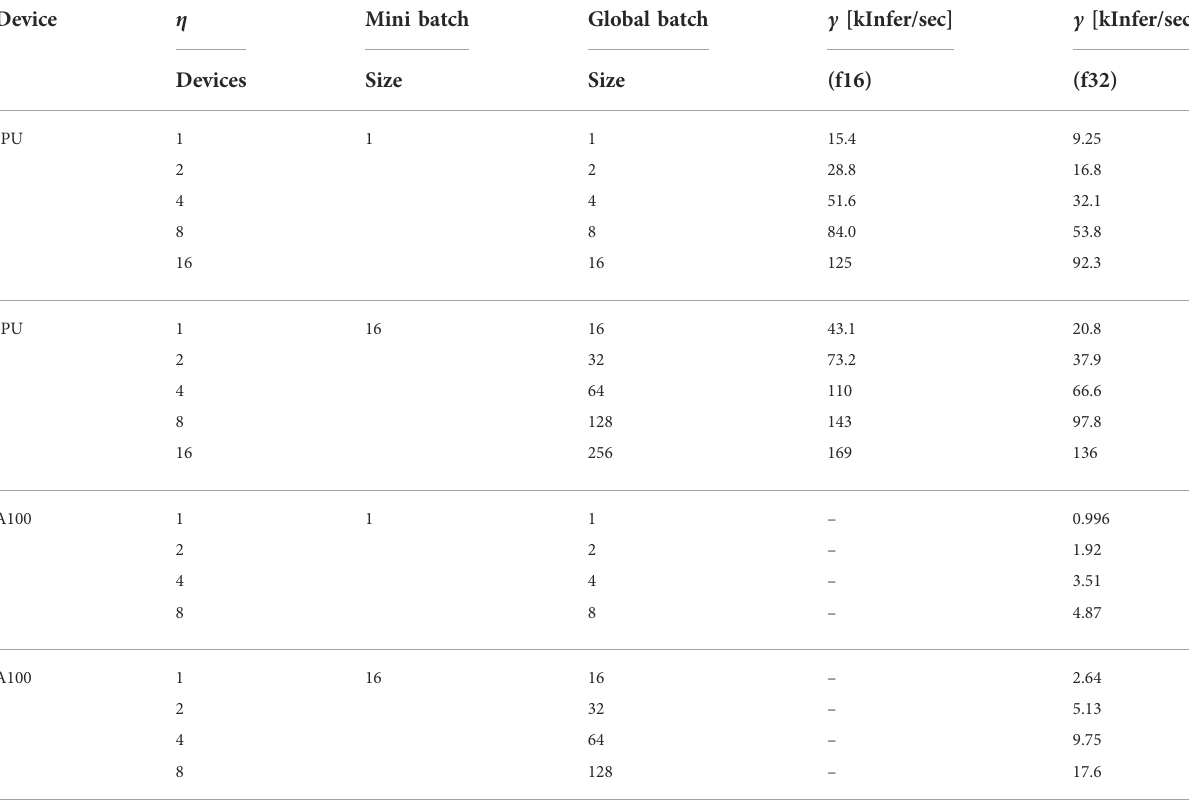
TABLE 3 Inferences per second for various conditions measured.